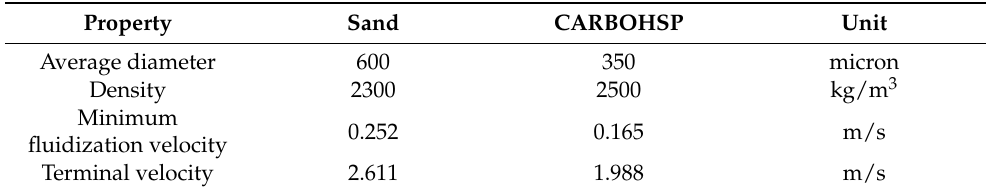
Table 2. Properties of the particles utilized in the numerical study.